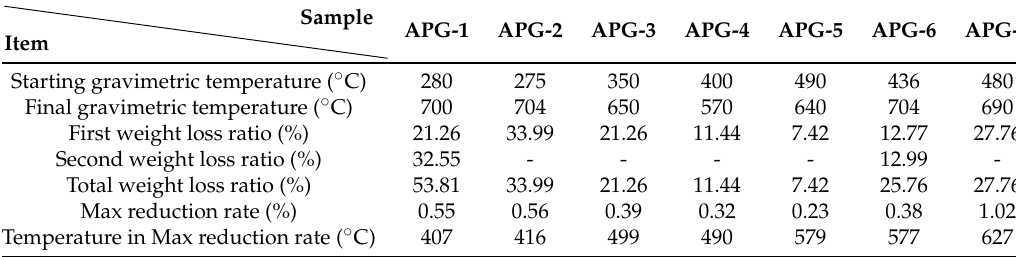
Table 2. Analyzed results of spent sulfur transfer catalysts’ reduction